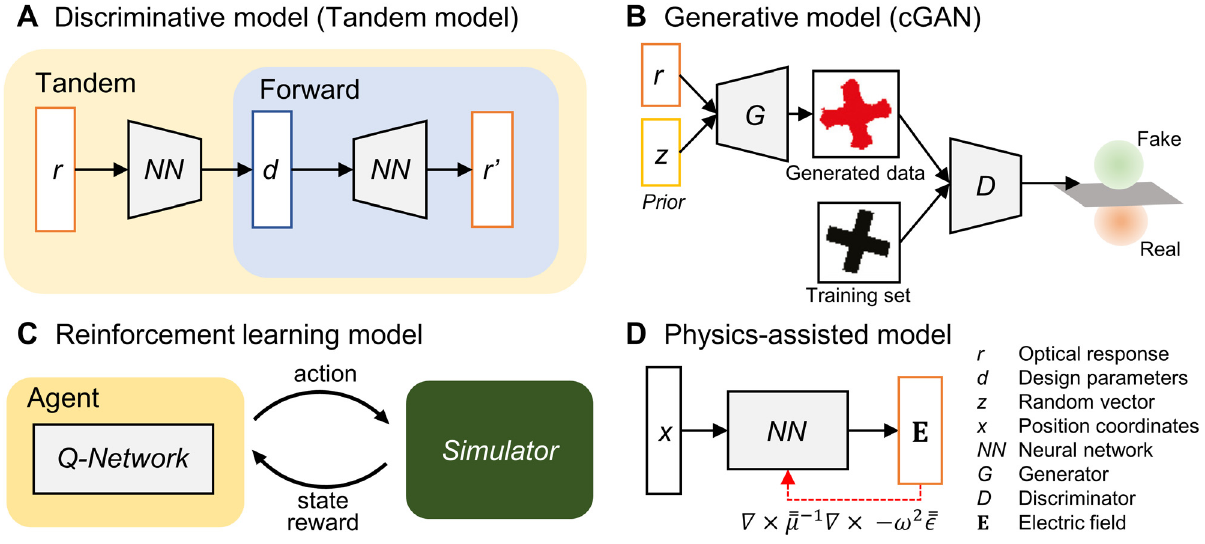
Figure 10: Schematic diagrams for each machine learning model used in nanophotonic device designs. ( A ) Tandem network is one type of discriminative model that is widely used for inverse-design of a device. ( B ) The fi gure depicts a conditional GAN(cGAN)architecturewhichtakestherequiredopticalconditionsasaninputandgeneratesatwo-dimensionaldesigngeometry. B Adapted with permission from [36]. Licensed under CC BY 4.0. ( C ) A schematic diagram of a reinforcement learning model involving a Q-network.